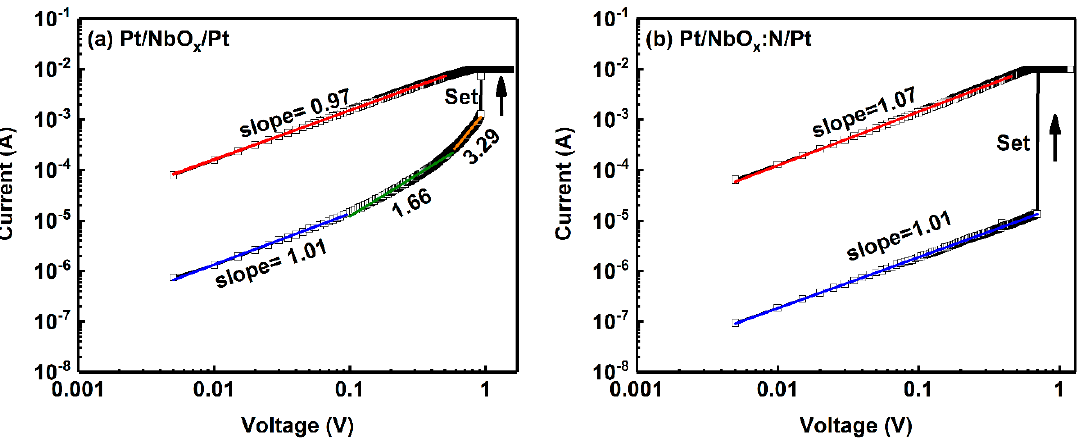
Figure 7. Double-logarithmic I - V curves of ( a ) Pt/NbO x /Pt and ( b ) Pt/NbO x :N/Pt memory devices. Standard errors of all fitted parameters were <0.01. Standard error values of fitting parameters and the overall fitting degree R 2 of the equation are detailed in Tables S1 and S2.